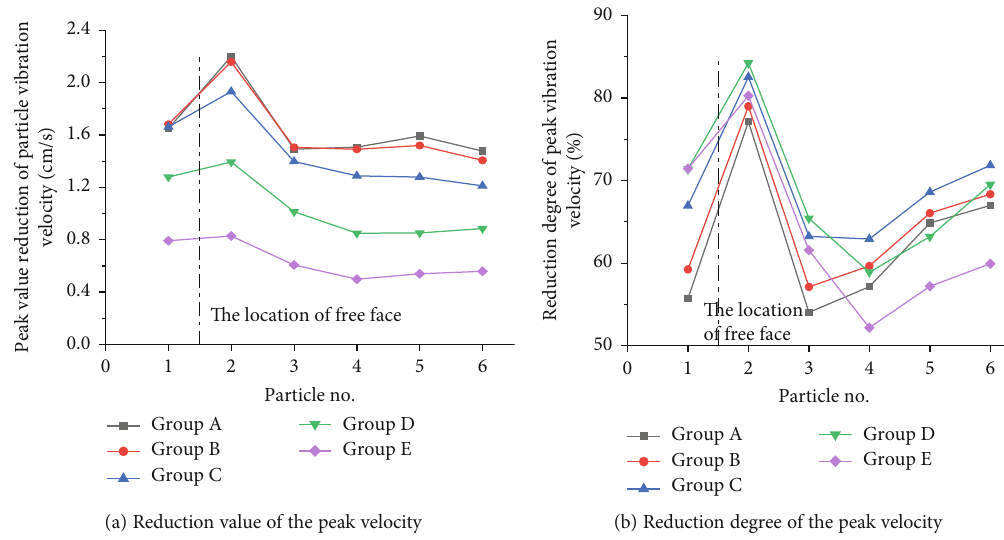
Figure 18: The di ff erence between peak vibration velocities for cases with/without free faces.